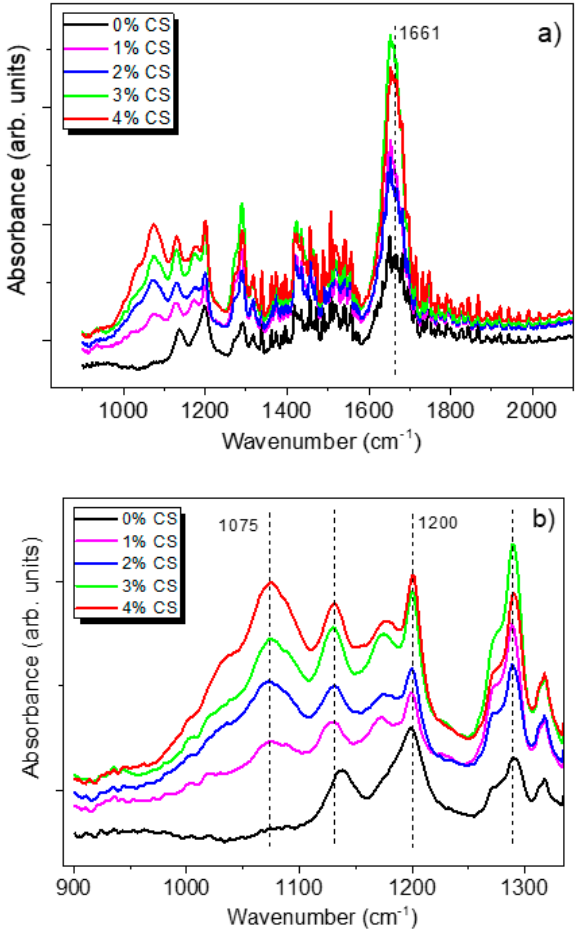
Figure 6. FTIR spectra of x%CS + 6%PVP fibre composites with x varied from 0% to 4% in the regions ( a ) 900–2100 cm − 1 (showing modulation of spectra by rotational bands of water) and ( b ) in the region 900–1350 cm − 1 where bands corresponding to CS increases in intensity at the increase in CS content. Vertical dashed lines show some peak position.